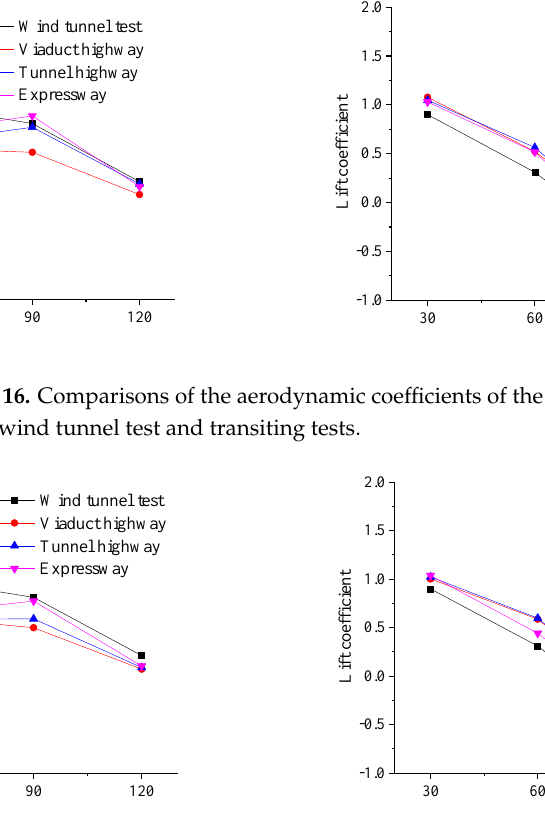
Table 5. Three times repeatability precision (×10 − 2 ) of aerodynamic coefficients from transiting tests conducted.